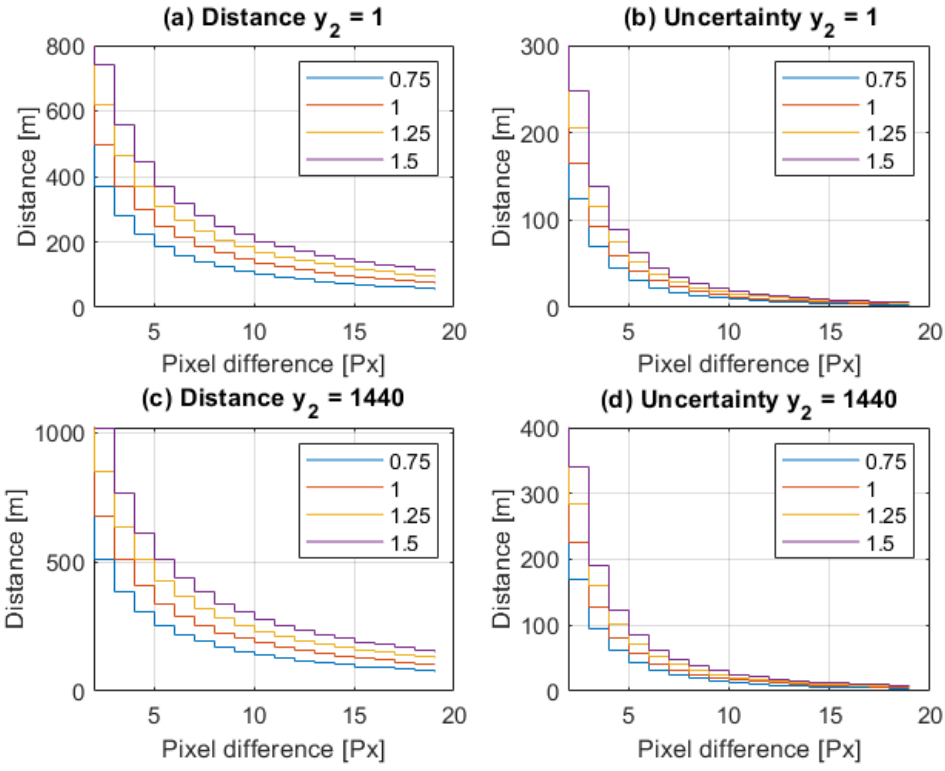
Figure 10. The distance measurement and its uncertainty as a function of the pixel difference for baseline B = (0.75, 1, 1.25, 1.5) m for different object placements on the image plane: y 2 = 1 in ( a ) and ( b ); y 2 = 1440 in ( c ) and ( d